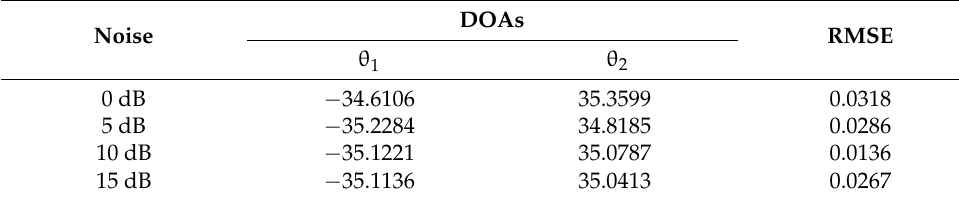
Table 3. DOA Estimation for Two Targets for N = 6 and M = 6 with Different Noises.